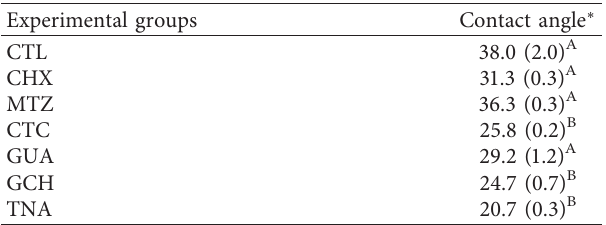
Figure 3: Color changes in demineralized dentin specimens after biodegradation in artificial saliva for four weeks. (a) CTL; (b) CHX; (c) MTZ; (d) CTC; (e) GUA; (f) GCH; and (g) TNA. Table 7: Contact angle formed by the adhesive system on dentin treated with different plant drug